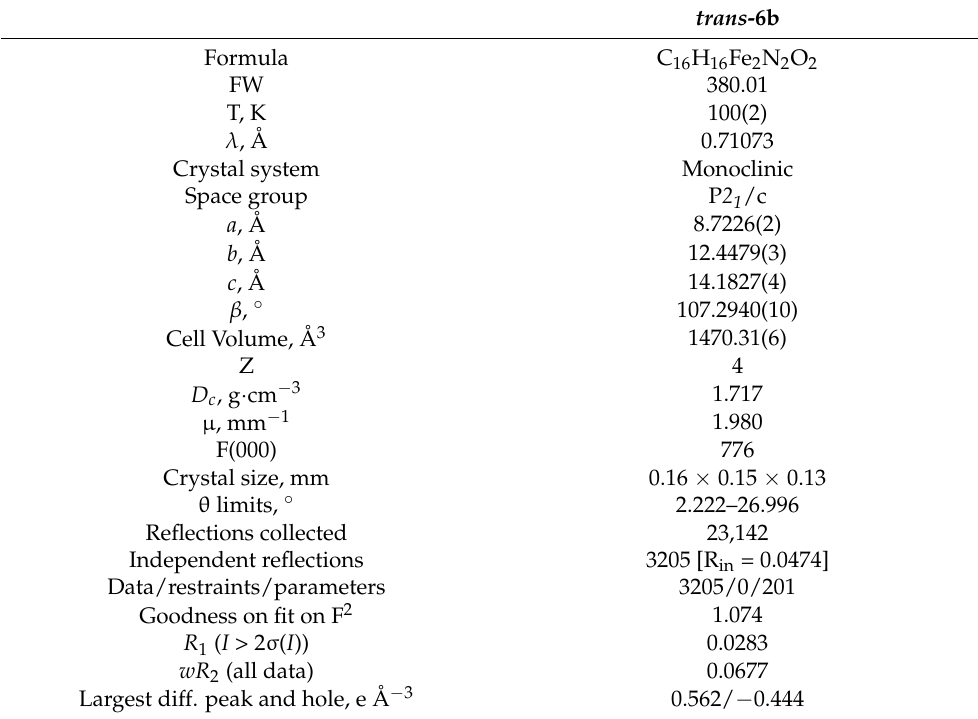
Table 1. Crystal data and measurement details for trans -6b